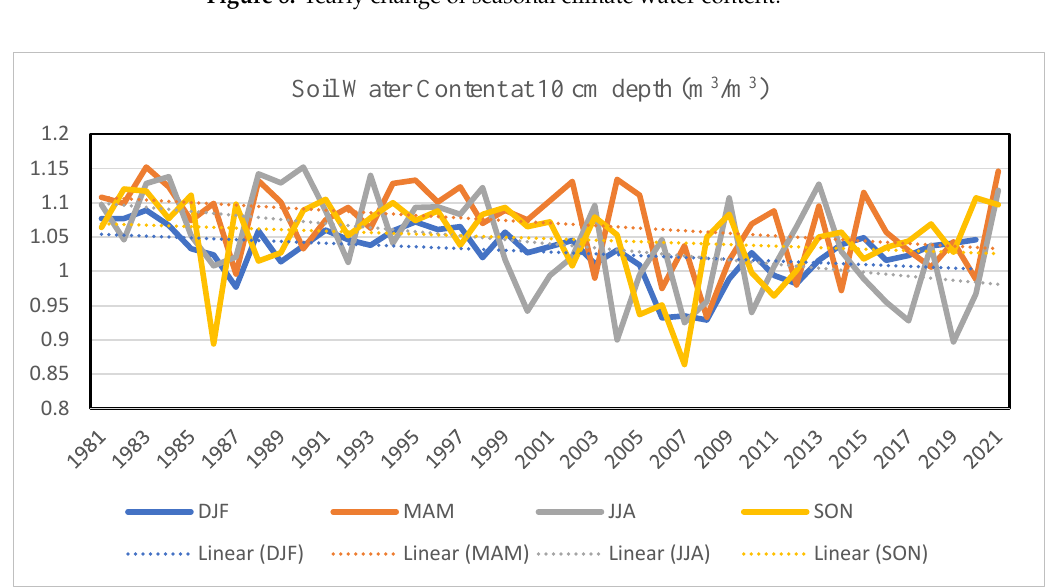
Figure 9. Yearly change of surface 10 cm soil water content.